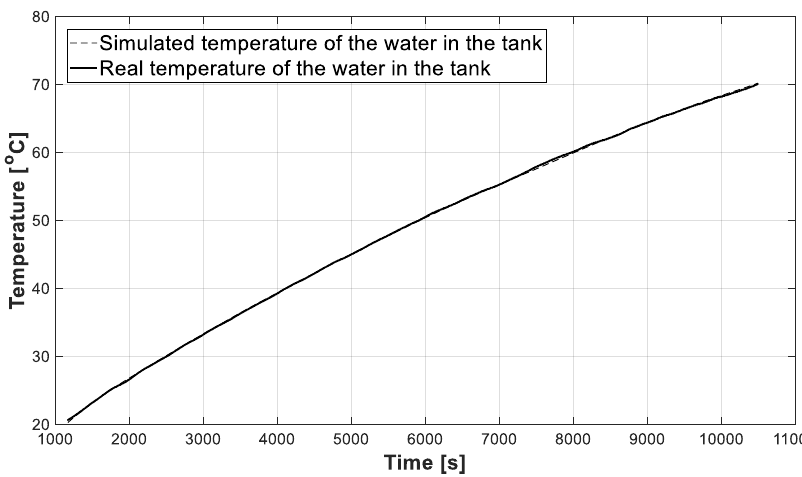
Figure 8. Comparison of the actual data with data simulated by the model.